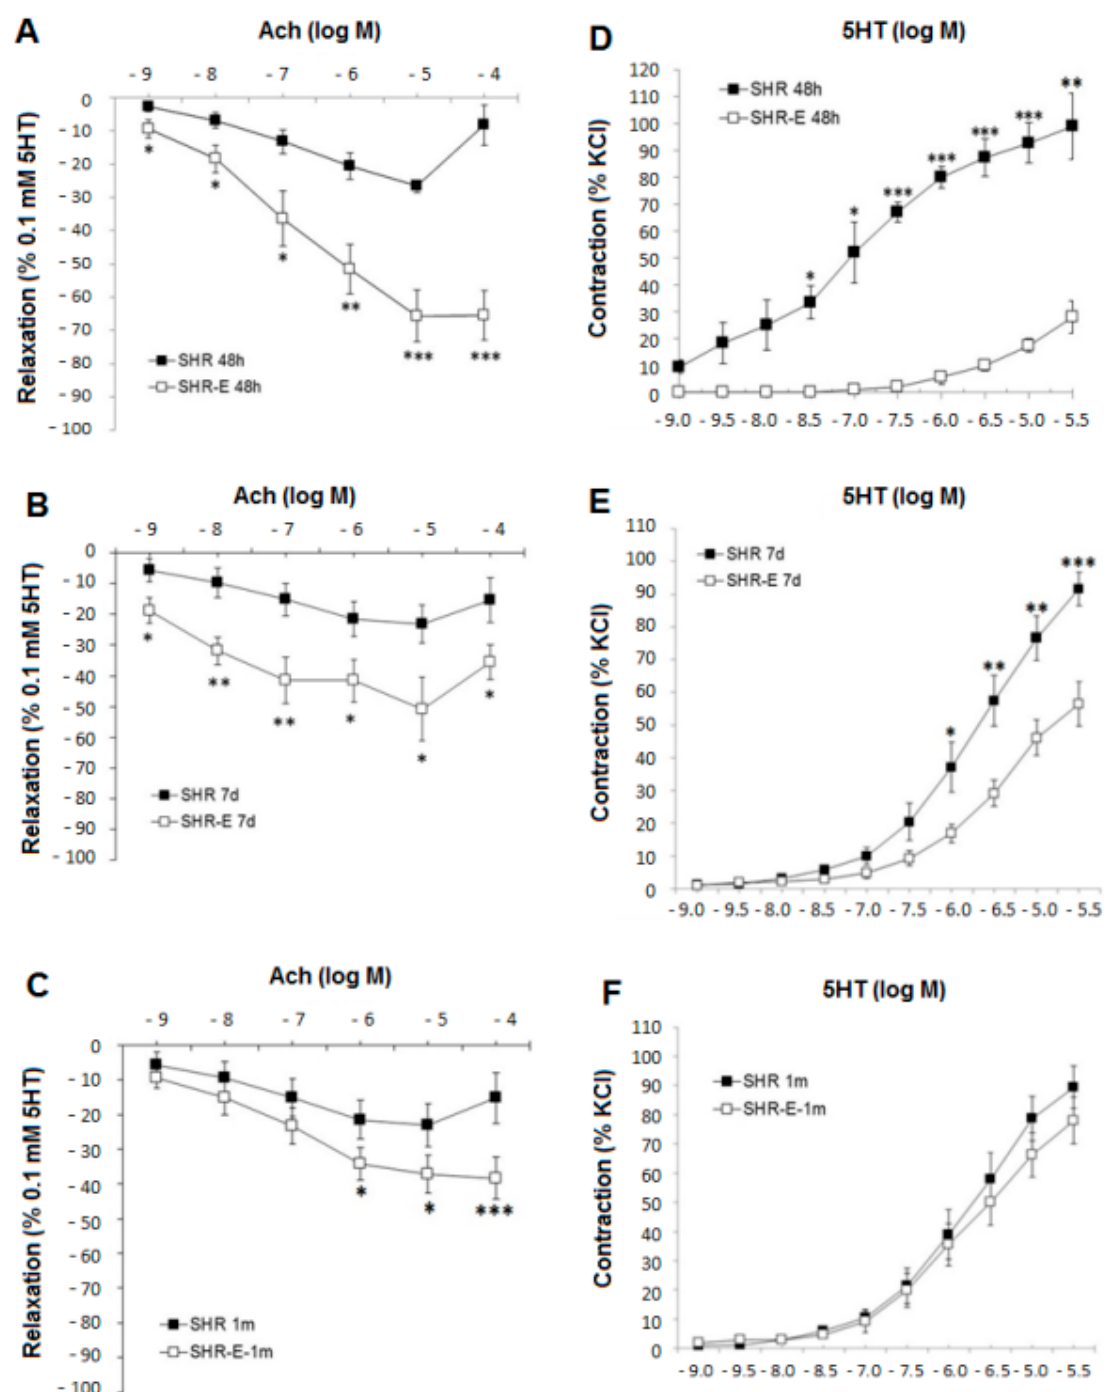
Figure 1. Concentration–response curves for acetylcholine on the coronary artery: ( A ) in treatment groups (48 h) and ( B ), ( C ) in withdrawal groups (7 days and 1 month). Concentration–response curves for serotonin on the coronary artery: ( D ) in treatment groups and ( E ), ( F ) in withdrawal groups (7 days and 1 month). SHRs, rats treated with vehicle; SHR-Es, rats treated with esmolol; n = 9 rats for each experimental group. Values are mean ± SEM. * p < 0.05, ** p < 0.01, *** p < 0.001 vs. SHRs.